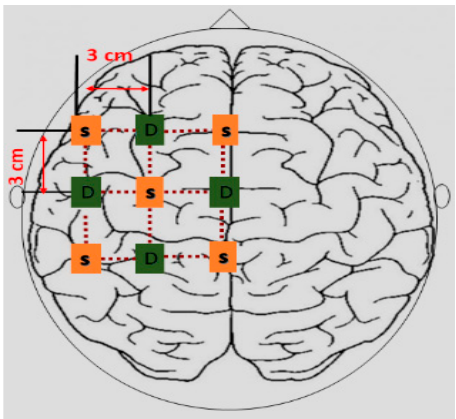
Figure 4. Position of source and detectors on the left hemisphere of the motor cortex. D represents the detectors and S represents sources .